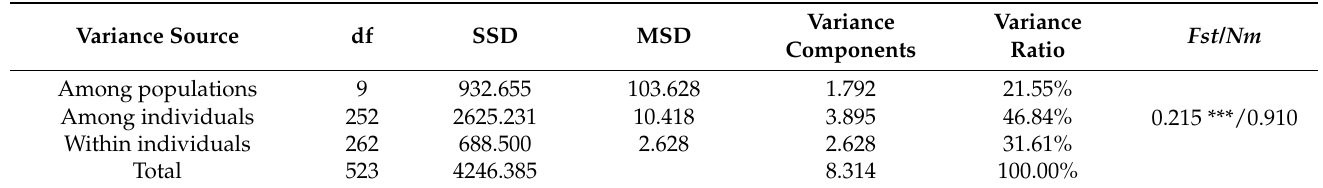
Table 2. Analysis of molecular variance (AMOVA) of 262 individuals in ten O. serrulatus